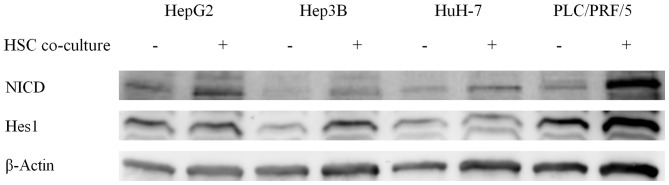
The effect of HSC co-culture on Notch signaling in HCC cell lines. HCC cell lines were co-cultured with HSC using a cell culture insert. After removing HSC cells, lysates were prepared from HCC cells. Immunoblot analyses were performed using antibodies against NICD and Hes1. Immunoblotting for β-actin levels was used to verify equal loading of cellular proteins. Representative blots of >3 independent experiments are shown. HSC, hepatic stellate cell; HCC, hepatocellular carcinoma.